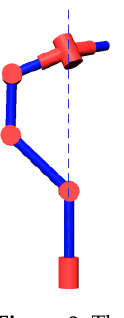
Figure 9. The configuration corresponding to condition 3.